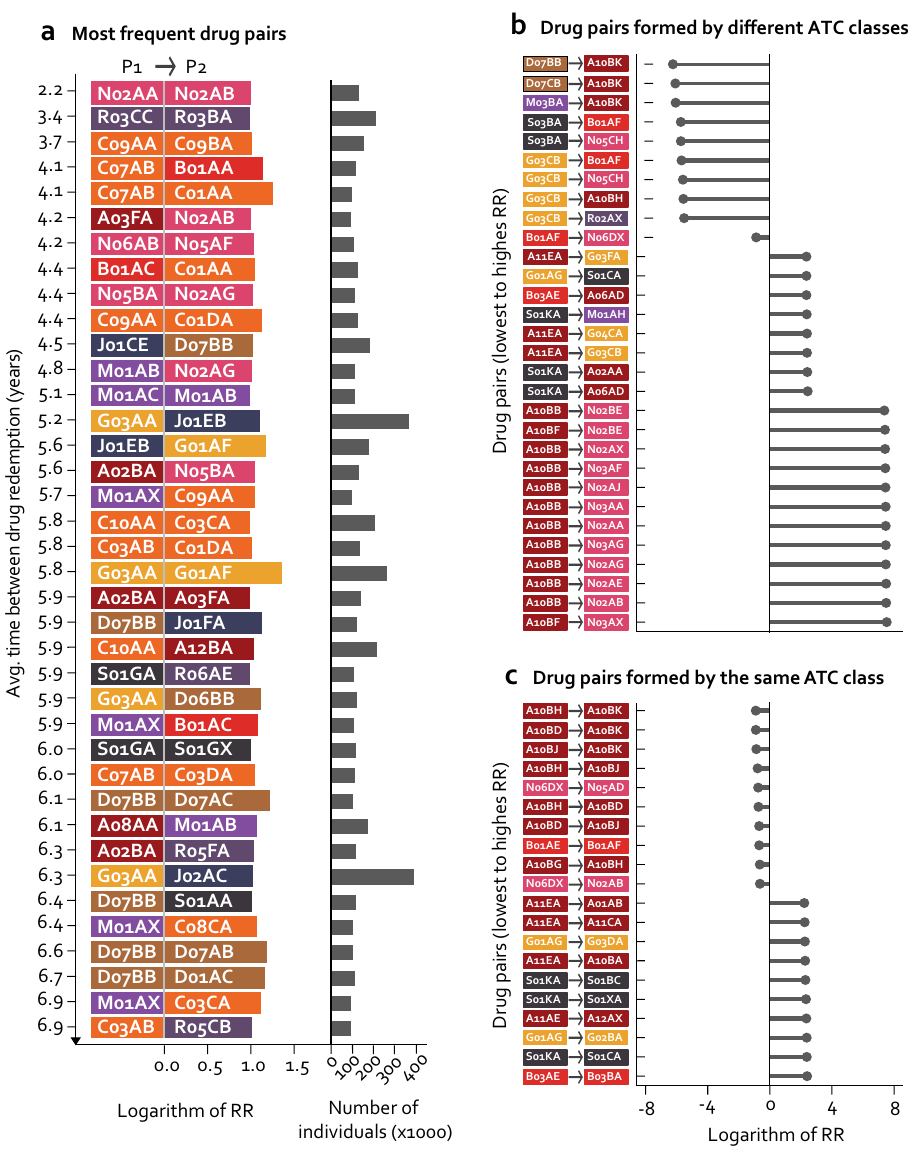
Fig. 2 Selected directional prescription pairs. a Attrition of prescription pairs following temporal statistical modeling. This includes the drug pair steps (P1 → P2) that were taken sequentially by over 100,000 individuals, had a relative risk ratio (RR) > 2 and a Q -value < 10 − 03 . Drug pairs were ordered vertically by time between P1 and P2 from shortest to longest time (top to bottom). Sizes of bars for each prescription (P1 and P2) are equal and correspond to the absolute number of the logarithm of its RR. The pair with the largest RR is G03AA → G01AF. The unannotated bars to the right indicate the number of individuals following each of the directional prescription pairs. b Drug pairs (P1 → P2) with the lowest and highest RR where P1 and P2 belong different ATC classes. c Drug pairs (P1 → P2) with the lowest and highest RR where P1 and P2 belong to the same ATC class. Pairs are ordered by RR, lowest to highest (top to bottom). *Refer to Fig. 1 for ATC group legend.